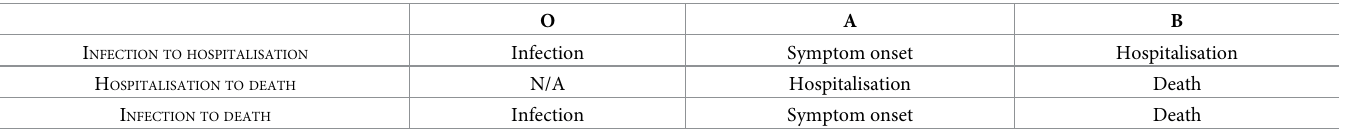
Table 1. Events O, A and B for the three time delay